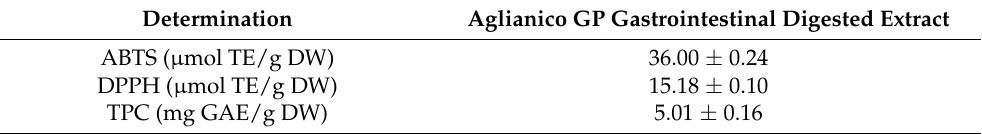
Table 1. Antioxidant activity and TPC of Aglianico GP gastrointestinal digested extract. Determination